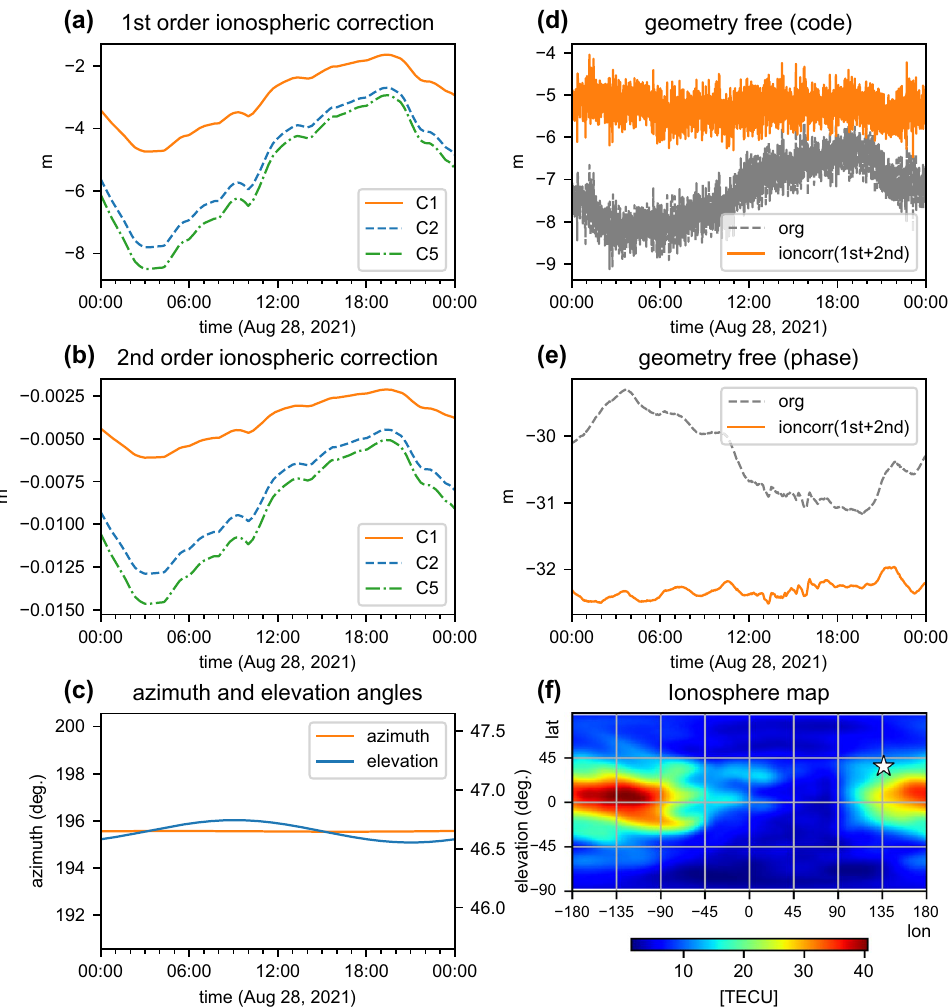
Fig. 4 Example of ionospheric correction. Corrected values for a first-order and b second-order ionospheric effects, c azimuth and elevation angles, changes in geometry free combination with/without ionospheric correction for d code and e phase, and f )global ionosphere map used for the correction. The QZSS J07 data of GEONET site “0255 (Komatsu)” (August 28, 2021) are shown. The IGS Global Ionosphere Map for the same day was